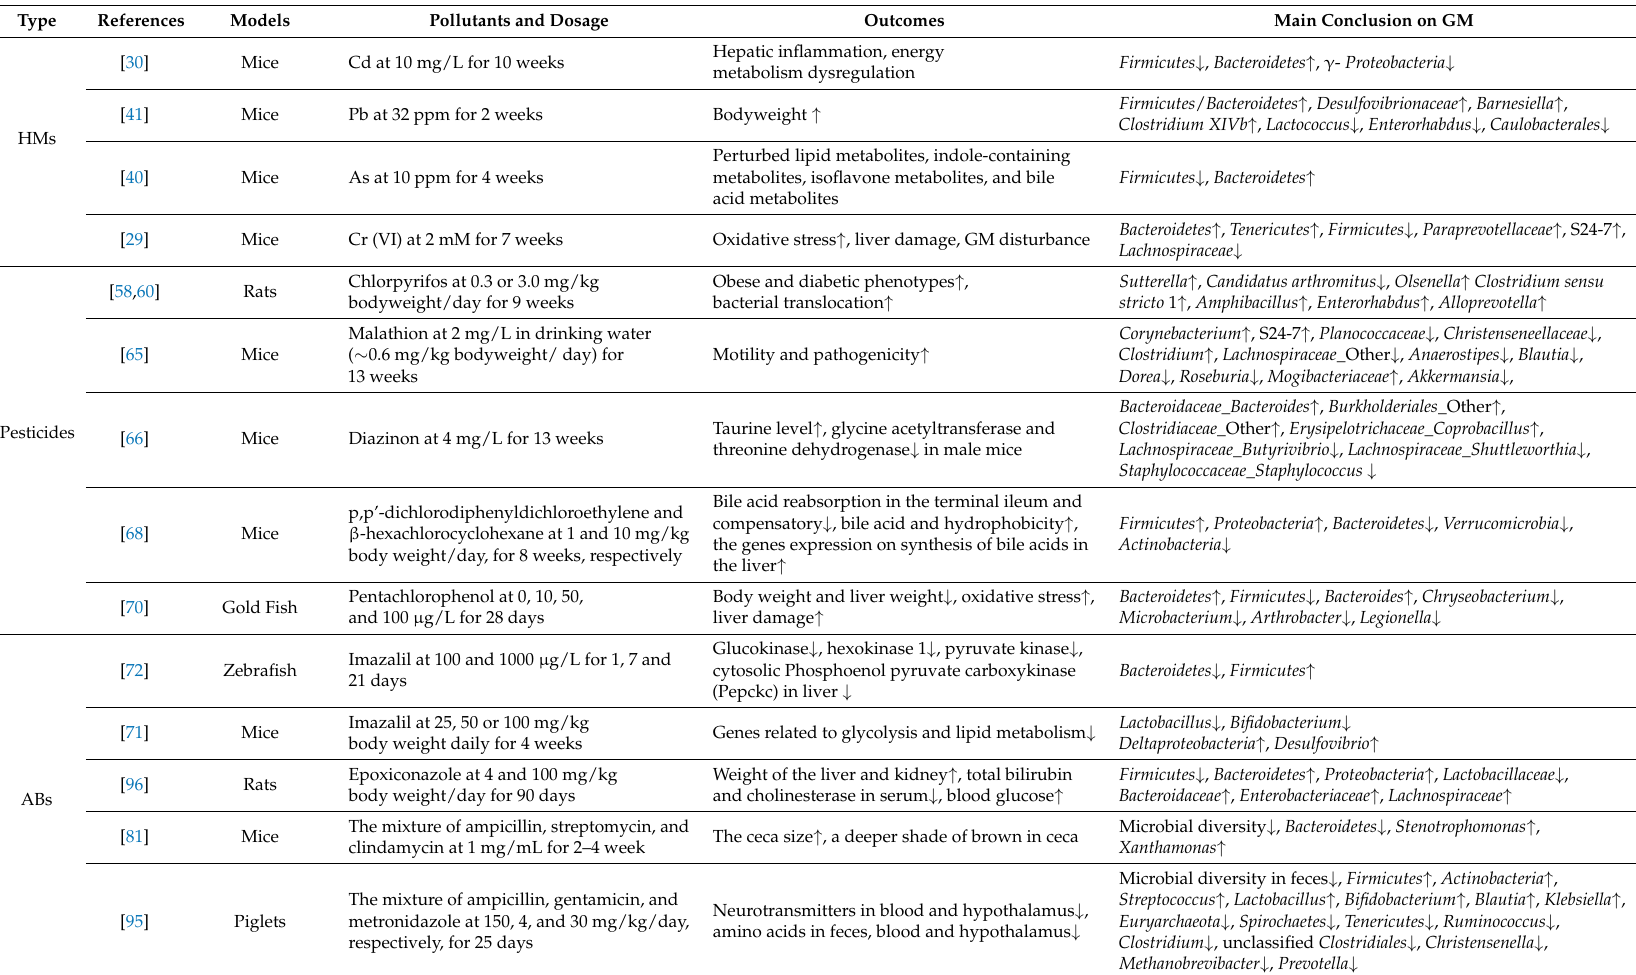
Table 1. Recent studies on the effects of foodborne contaminants on hosts and